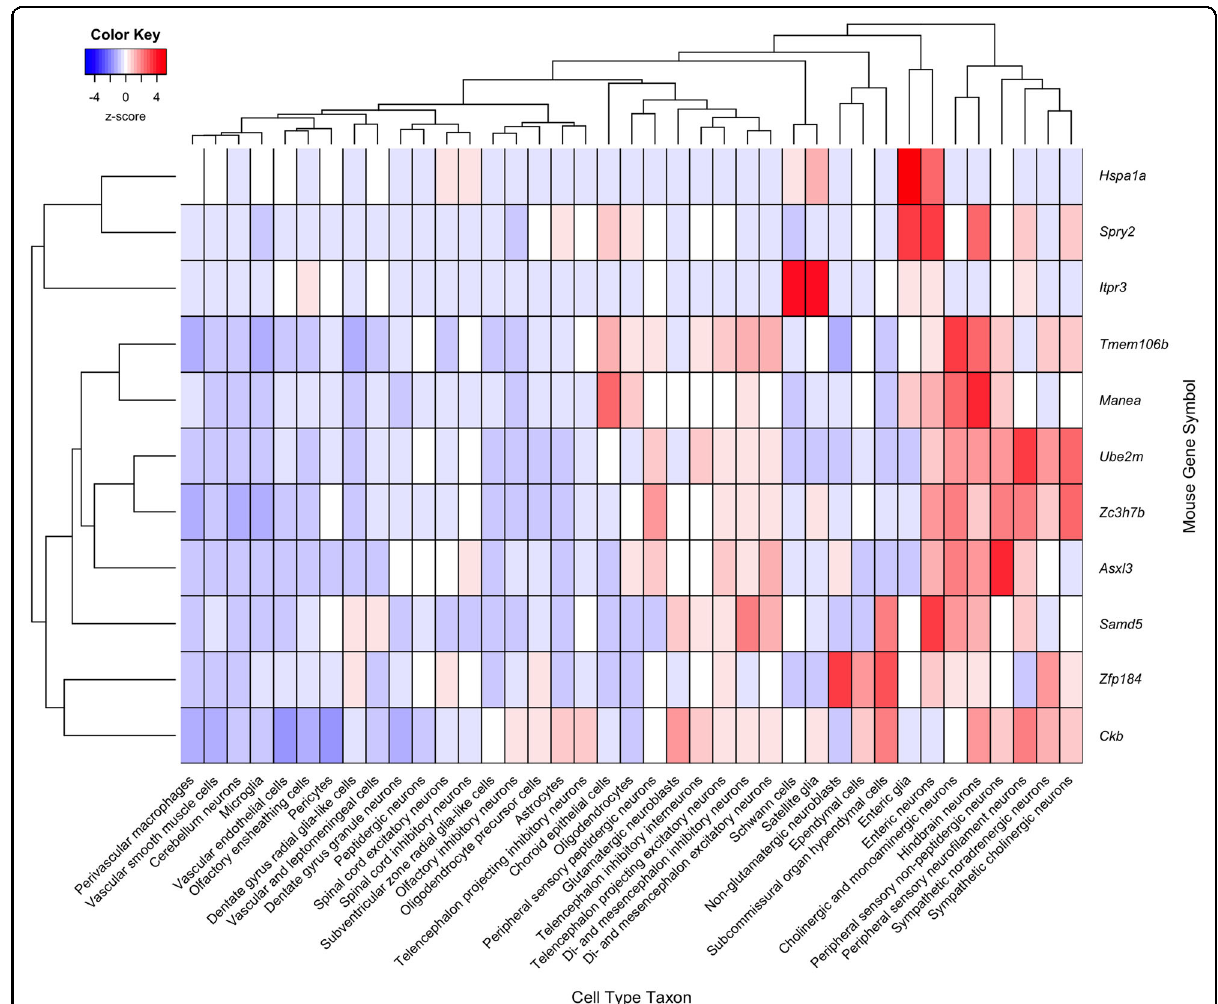
Fig. 3 Expression heatmap for the top differentially expressed genes across the 39 mouse cell-type taxa. Cell colours range from blue to red, which represent depleted and speci fi c expression, respectively. LST1 is not shown because it lacks a homologous mouse gene in the Homologene